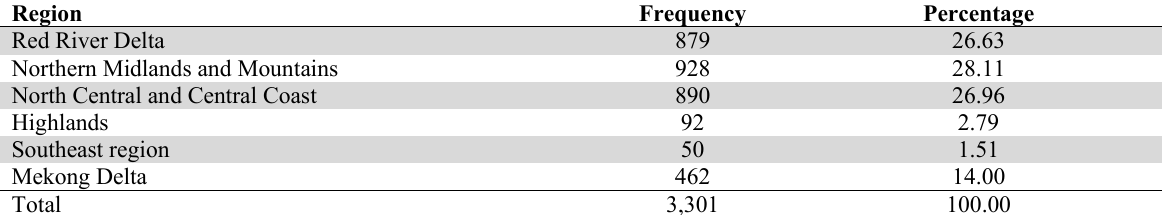
100.00 Source: The authors’